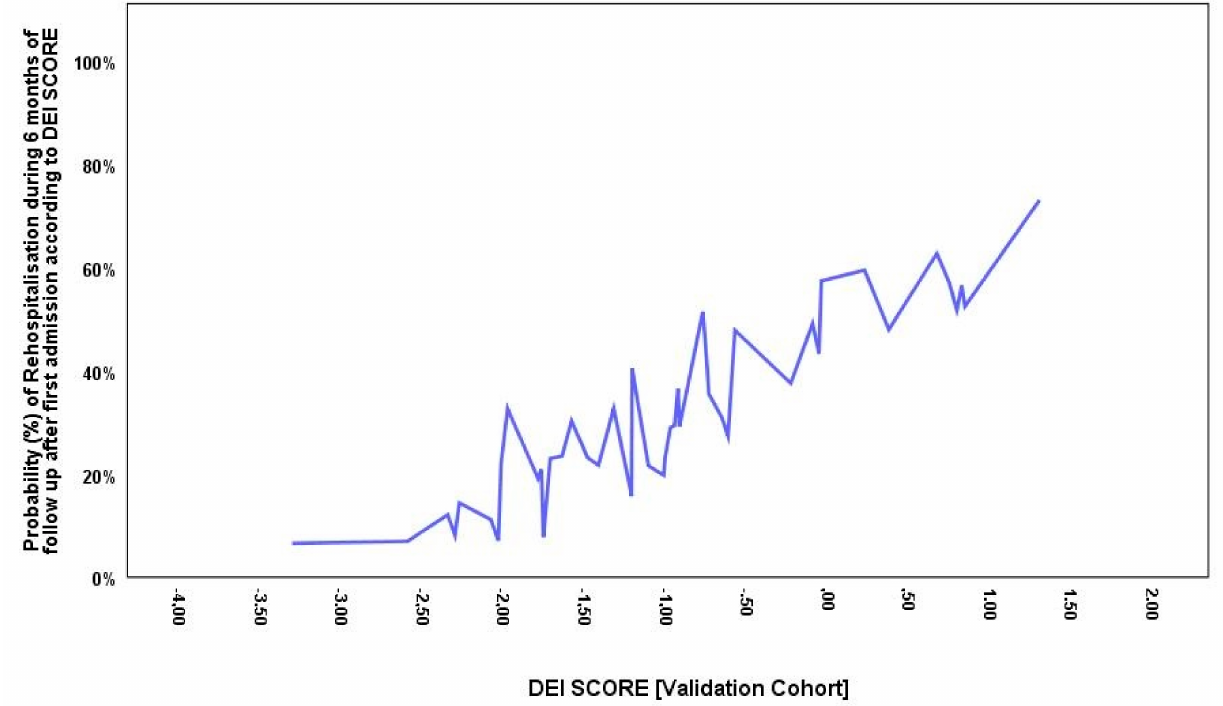
Figure 5. Probability plot of the rehospitalization during six months of follow-up after the first admission according to DEI score, according to the validation